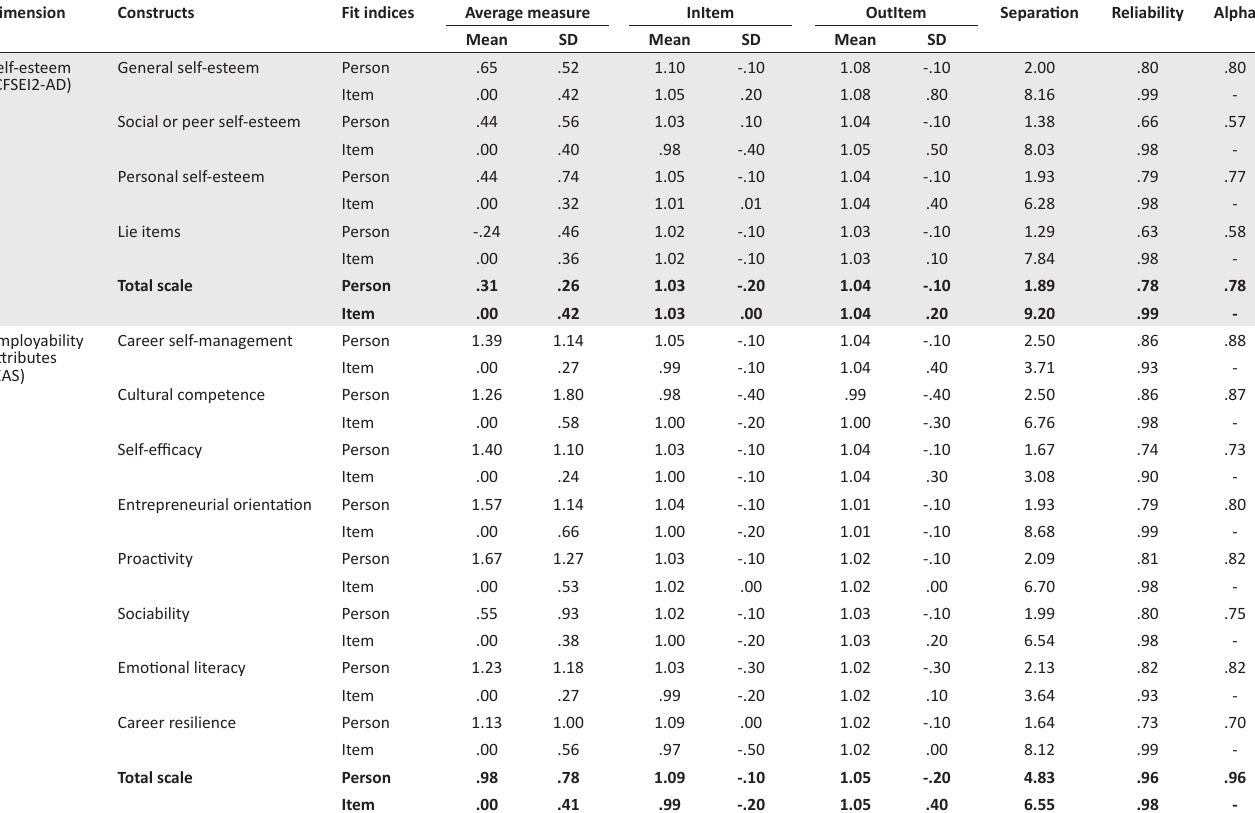
TABLE 1: Person and item reliability – Culture Free Self-Esteem Inventory and Employability Attributes Scale.